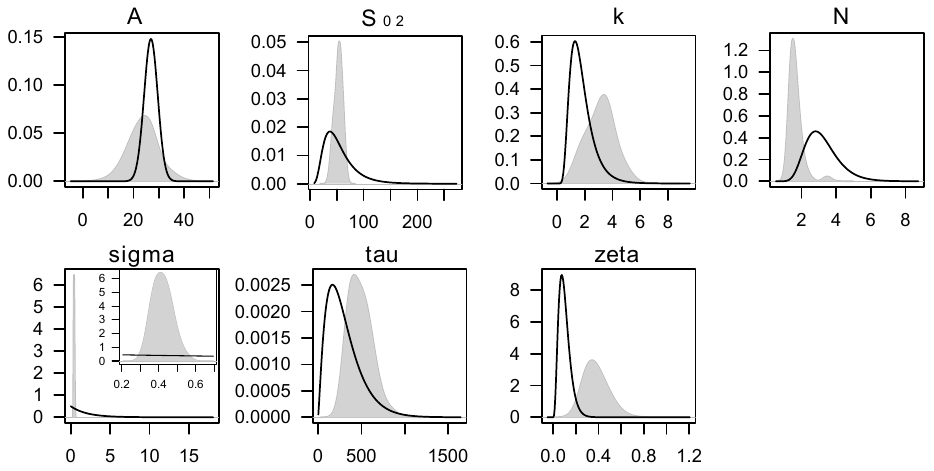
Fig. 3. Prior (solid line) and posterior distribution (gray area) of model